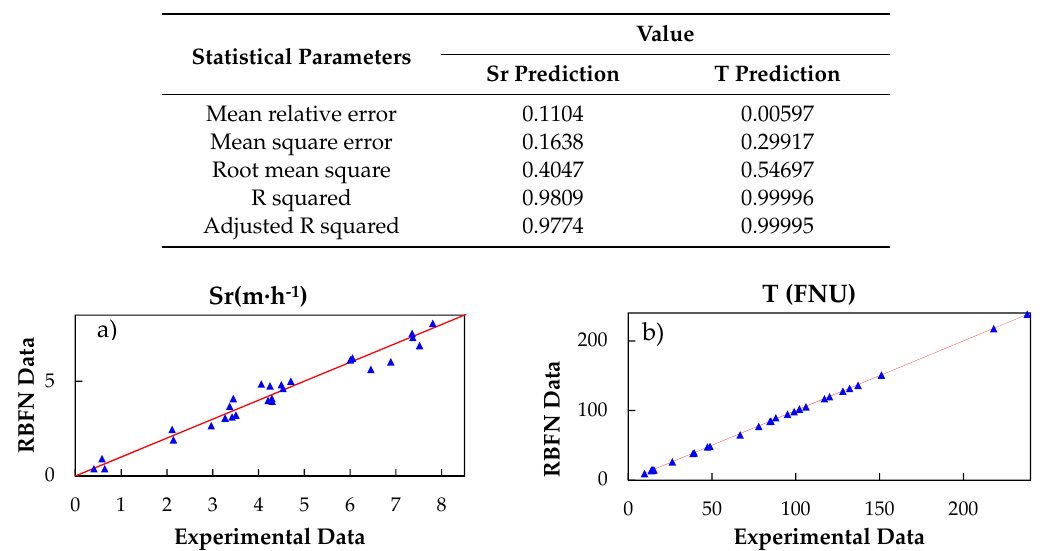
Figure 8. Comparison between experimental data and predicted data by the Radial Basis Function Network (RBFN) model for ( a ) Settling rate (Sr), ( b ) Turbidity (T).